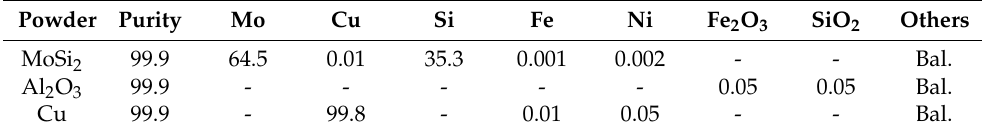
Table 1. Al 2 O 3 –MoSi 2 mix particles and Cu particles of feedstock materials ( ω t. %).